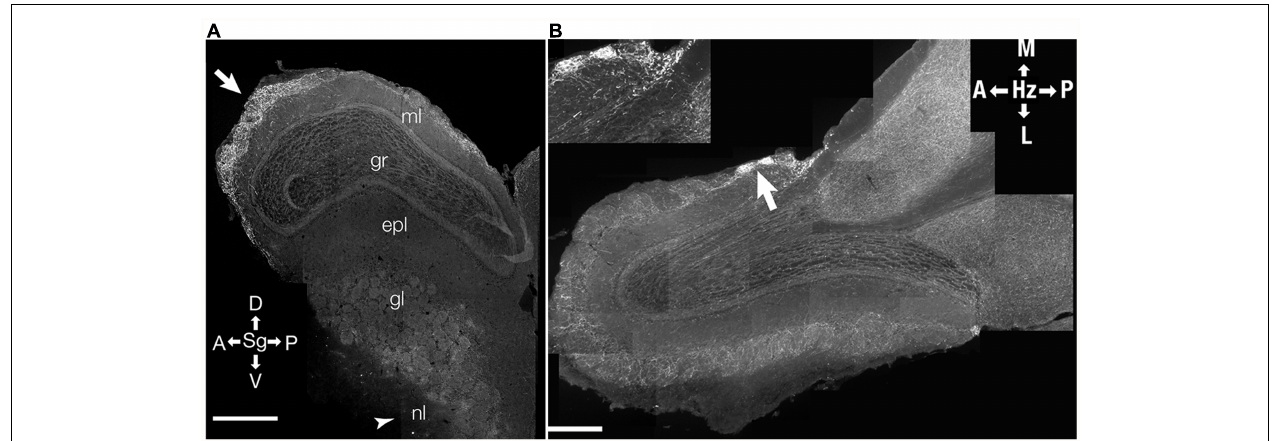
found. ml- mitral cell layer; gr, granule cell layer; epl, external plexiform layer; gl, glomerular layer; nl, olfactory nerve layer. (B) Micrograph of a horizontal (Hz) cross-section of the OB. Arrow points to heavily stained atypical glomeruli shown in inset. (B inset ) High-resolution micrograph of two atypical glomeruli with a relatively high amount of GFP staining. D, dorsal; V, ventral; A, anterior; P, posterior; L, lateral; M, medial. Data, with permission, from Salcedo etal.